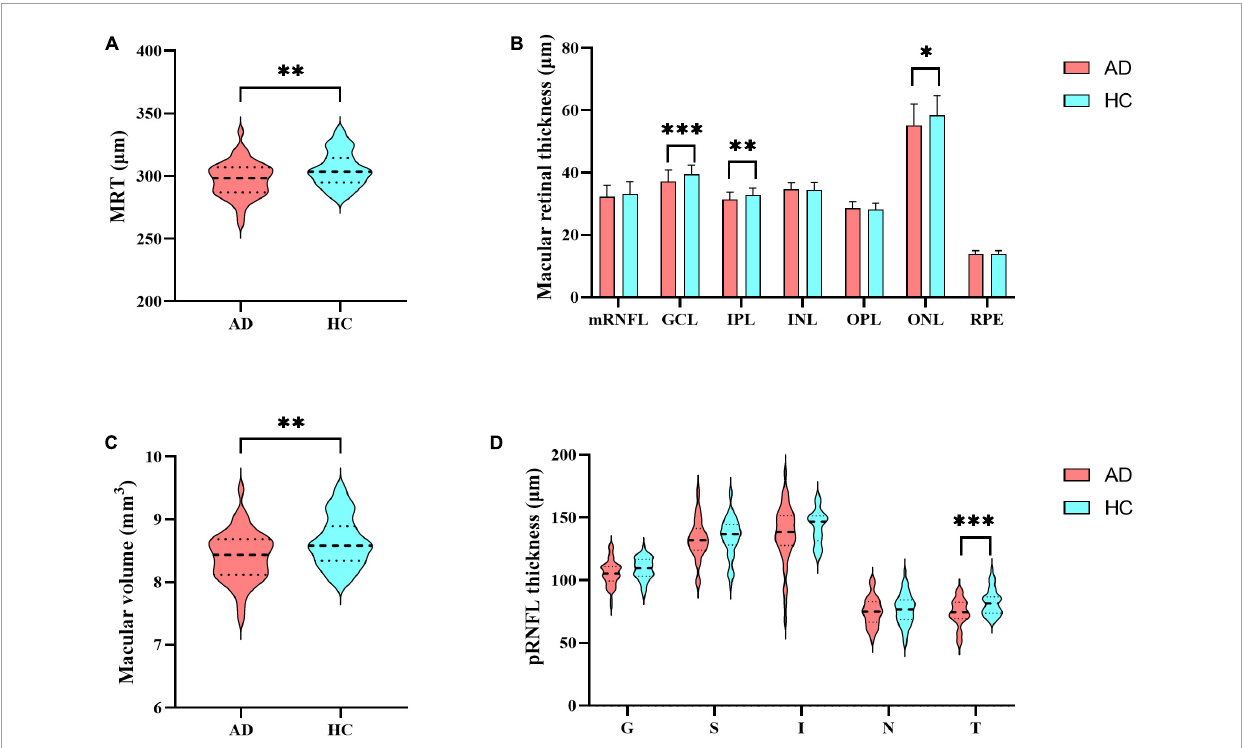
FIGURE1 Differences in retinal thickness. (A) Mean retinal thickness; (B) the thickness of retinal layers in the macular region: mRNFL, GCL, IPL, INL, OPL, ONL and RPE; (C) macular volume; (D) peripapillary RNFL (pRNFL) thickness: global thickness (G), superior quadrant (S), inferior quadrant (I), nasal quadrant (N), temporal quadrant (T). MRT, mean retinal thickness; mRNFL, macular retinal nerve fiber layer; GCL, ganglion cell layer; IPL, inner plexiform layer; INL, inner nuclear layer; OPL, outer plexiform layer; ONL, outer nuclear layer; RPE, retinal pigment epithelium; pRNFL, peripapillary RNFL; G, global thickness; S, superior quadrant; I, inferior quadrant; N, nasal quadrant; T, temporal quadrant. Significant differences are indicated by square brackets. ∗ Denotes p < 0.05, ∗∗ denotes p < 0.01, and ∗∗∗ denotes p < 0.001.